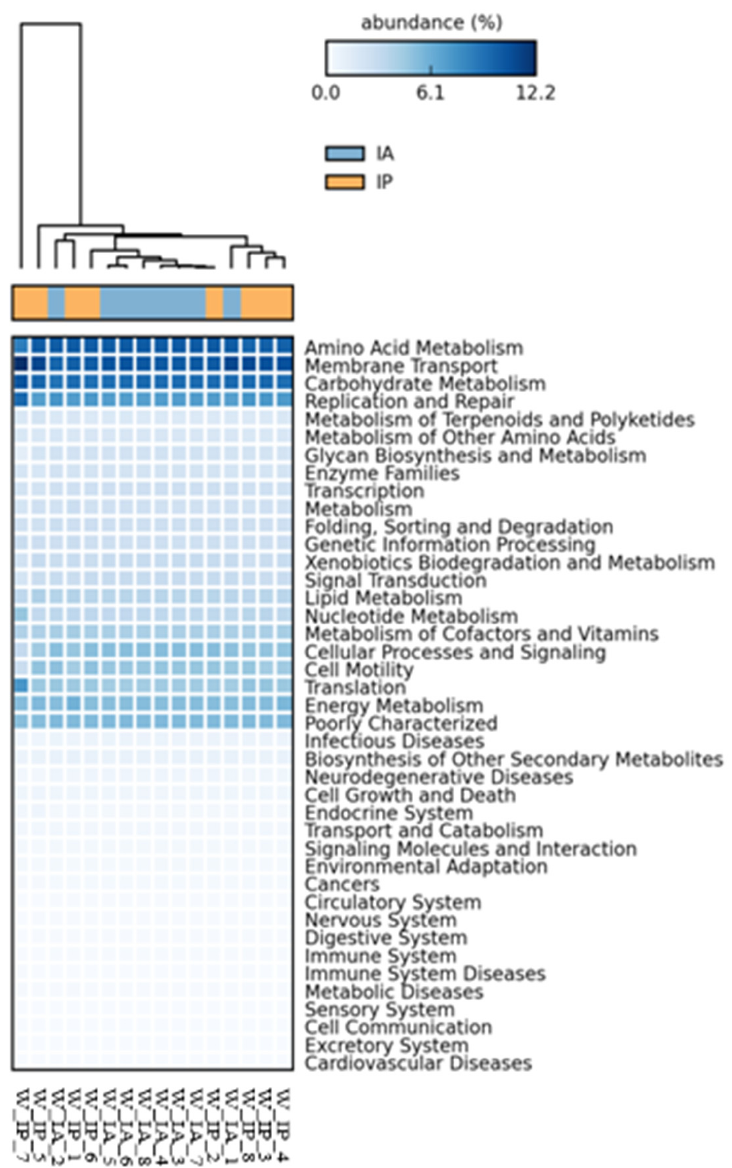
Figure 5. General metabolic pathways of the intestinal microbiota from both sections of wild C. labrosus . In the figure, W_IA corresponds to the anterior intestinal section of wild fish, and W_IP corresponds to the posterior intestinal section of wild fish.